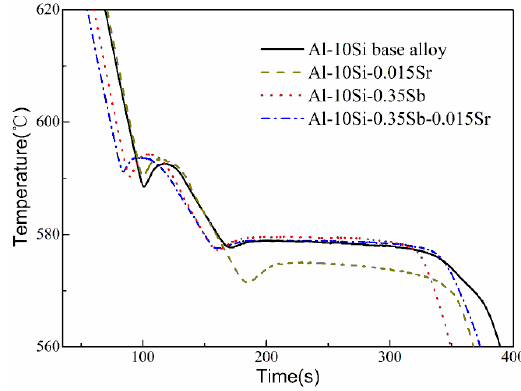
Figure 1. Cooling curves of Al–Si base and modified alloys. Table 2. Characteristic temperature in the cooling curves.